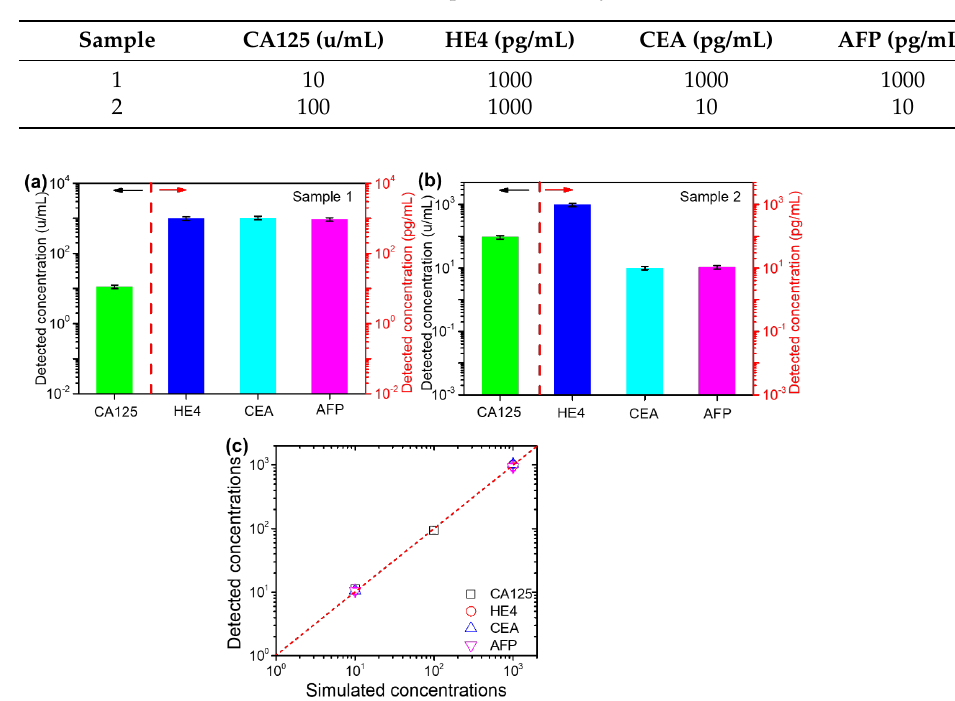
Figure 4. The detection selectivity of ( a ) CA125, ( b ) HE4, ( c ) CEA and ( d ) AFP in the samples. The error bars are from three different tests. Table 1. Concentrations of the biomarkers spiked in healthy serum.